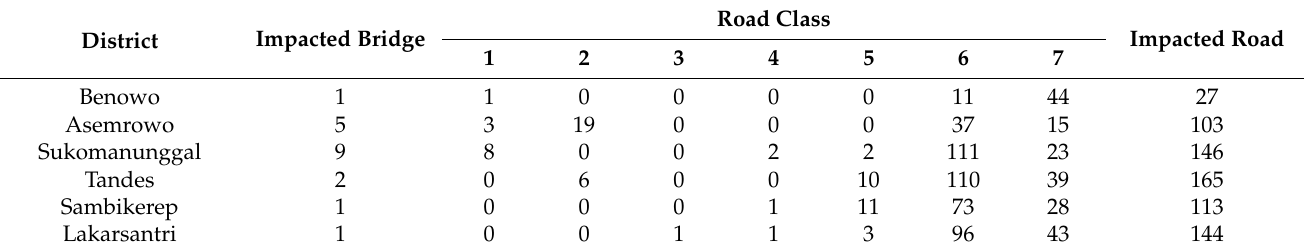
Table 1. The distribution of impacted infrastructure by district.